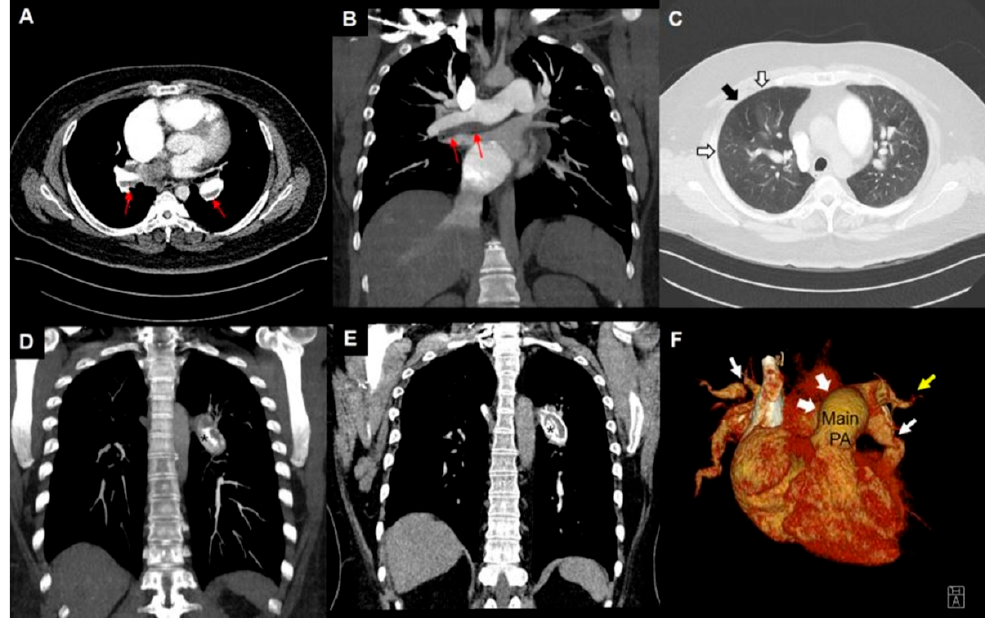
Figure 6. CT findings suggestive of CTEPH. Eccentric thrombus along the wall ( A , B ). Mosaic attenuation ( C ). Calcified thrombus (asterisks, ( D , E )). Three-dimensional volume rendering image showing dilated main PA (arrowhead) and narrowing (white arrow) and pruning (yellow arrow) of PA ( F ).